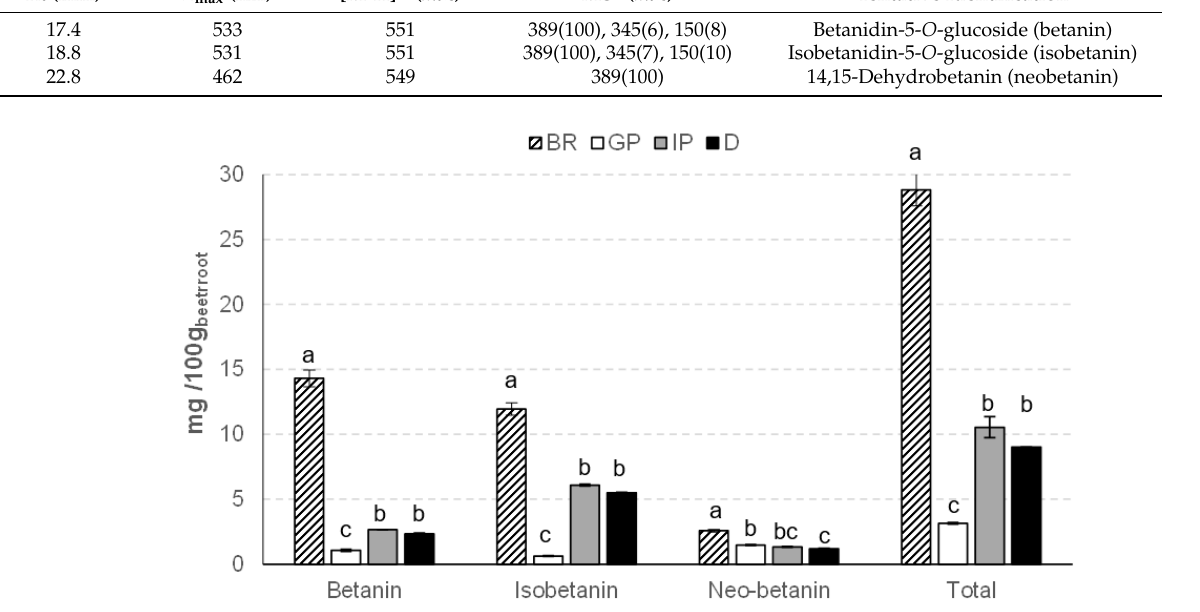
Figure 4. Betacyanins content (mg/100 g fw of beetroot) in beetroot (BR), gastric phase (GP), intestinal phase (IP), and digested (D) sample. For each betacyanin compound, different letters indicate significant differences ( p < 0.05) between samples.